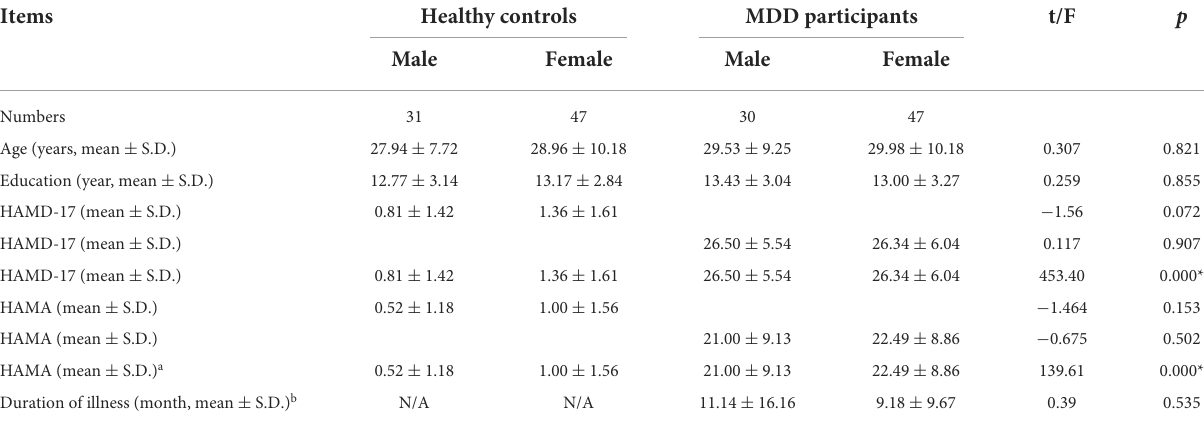
TABLE 1 Demographics and clinical data of